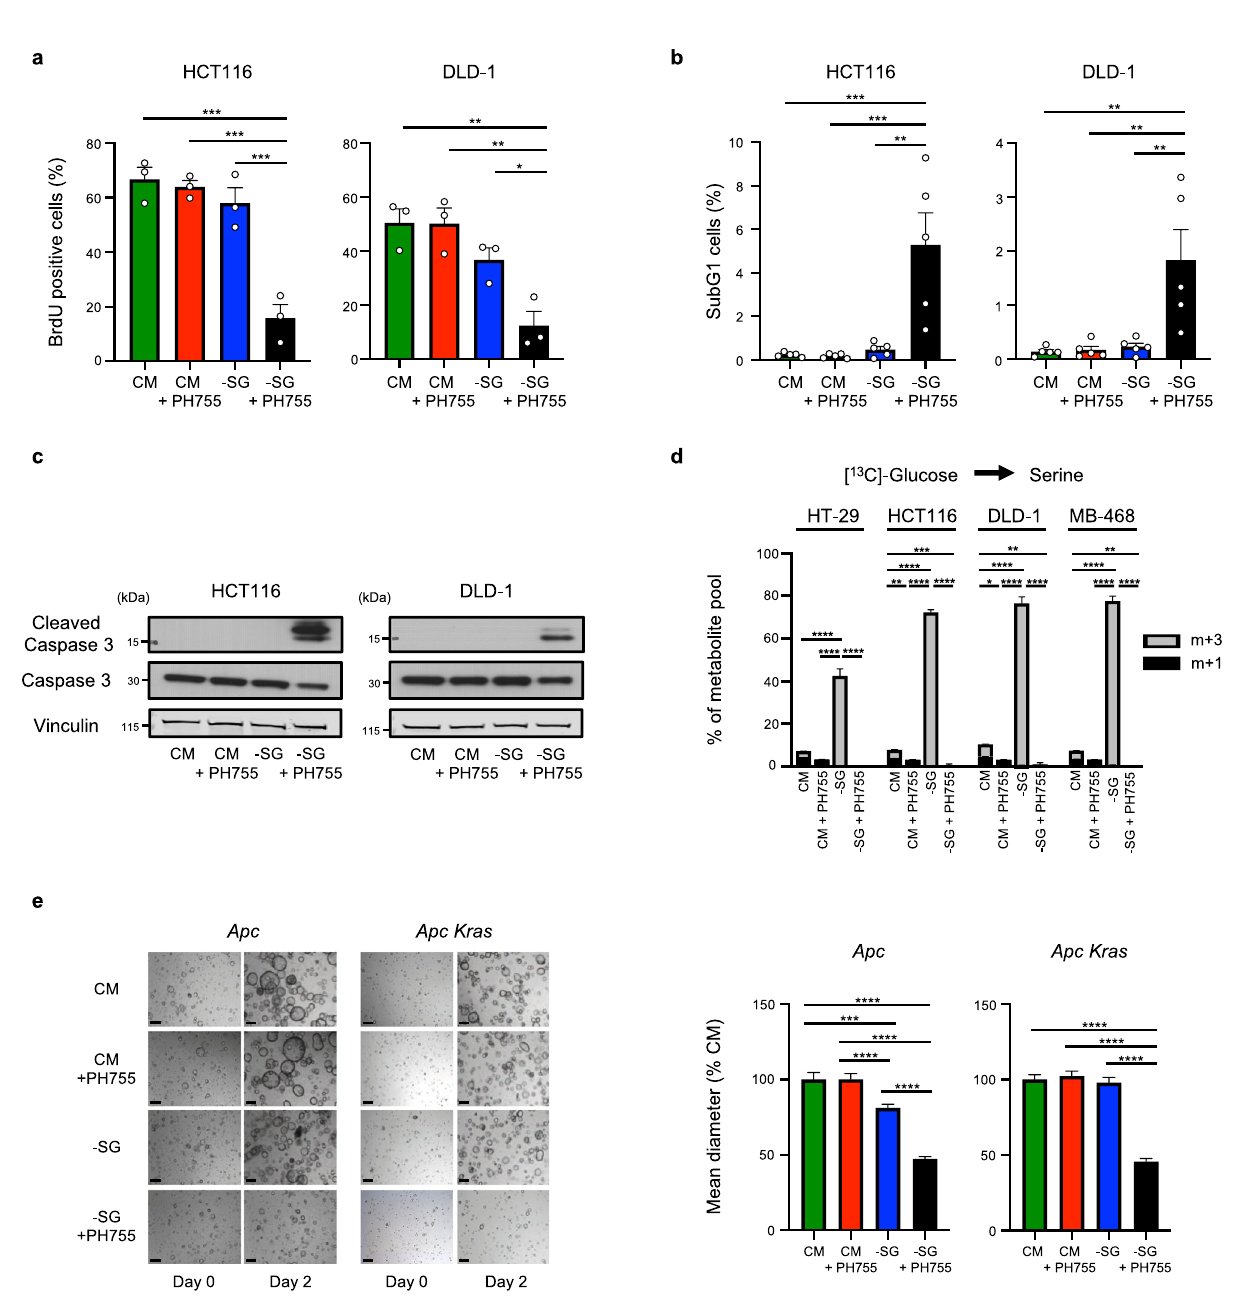
Fig. 2 PHGDH inhibition cooperates with serine/glycine depletion to limit DNA synthesis, survival and organoid growth. a Percentage of BrdU positive cells in HCT116 and DLD-1 cells grown in CM or -SG medium ±10 µ M PH755 for 48 h followed by a 5-h incubation with 10 µ M BrdU. Data represents mean ± SEM of three independent experiments (* p < 0.05, ** p < 0.01, *** p < 0.001, one-way ANOVA with Tukey ’ s post hoc test). b Percentage of SubG1 cells in HCT116 and DLD-1 cells grown in CM or -SG medium ±10 µ M PH755 for 48 h. Data represents mean ± SEM of fi ve independent experiments (** p < 0.01, *** p < 0.001, one-way ANOVA with Tukey ’ s post hoc test). c Cells were grown in CM or -SG medium supplemented or not with 10 µ M PH755 for 2 days (HCT116) or 3 days (DLD-1). Western blots show the expression of cleaved Caspase-3 and Caspase-3. Membrane was reprobed with vinculin as a loading control. Data are representative of three independent experiments. d Intracellular serine level in cells grown in CM or -SG medium ±10 µ M PH755 containing U-[ 13 C]-glucose was measured by LC-MS. Metabolite percentages are represented as mean ± SEM of triplicate cultures and are representative of three independent experiments (* p < 0.05, ** p < 0.01, *** p < 0.001, **** p < 0.0001; one-way ANOVA with Tukey ’ s post hoc test). e Intestinal tumour organoids derived from Vil1-creER;Apc fl / fl ( Apc ) and Vil1-creER;Apc fl / fl ;Kras G12D/ + ( Apc Kras ) mice were grown in CM or -SG medium supplemented or not with 10 µ M PH755. Left panel: representative pictures of the organoids are shown before (day 0) and 2 days after medium change. Right panel: quanti fi cation of organoid diameter 2 ( Apc ) or 4 days ( Apc Kras ) after medium change. Data are presented as mean ± SEM ( n = number of organoids measured per condition; Apc : CM: n = 113, CM + PH755: n = 200, -SG: n = 190, -SG + PH755: n = 158; Apc Kras: CM: n = 149, CM + PH755: n = 134, -SG: n = 134, -SG + PH755: n = 78) and are representative of at least two independent experiments (*** p < 0.001, **** p < 0.0001; one-way ANOVA with Tukey ’ s post hoc test). Scale bar represents 200 μ